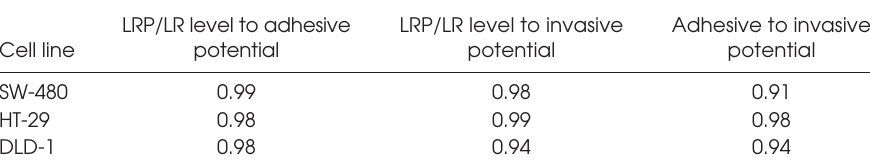
Table 3. Pearson’s correlation coefficients between total LRP/LR levels and the adhesive and invasive potential of early-stage (SW-480 and HT-29) and late-stage (DLD-1) colorectal cancer